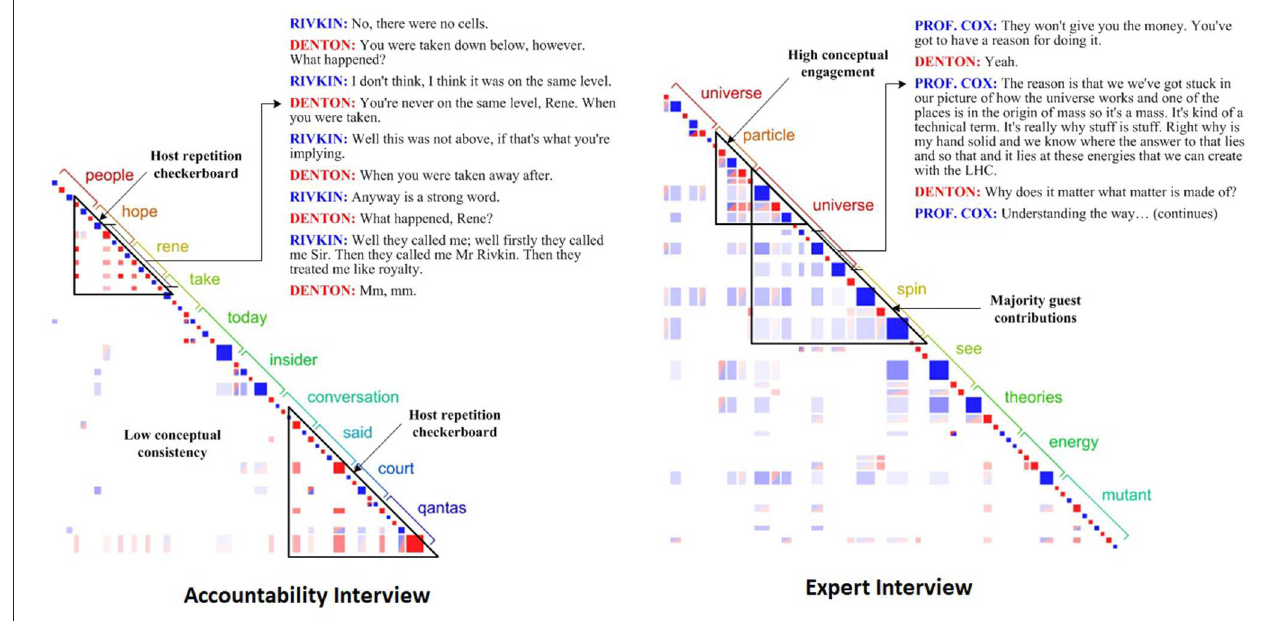
FIGURE 2 | Conceptual recurrence plots of accountability and expert interviews from the Enough Rope television program. Reproduced from Angus et al. [44] with permission.